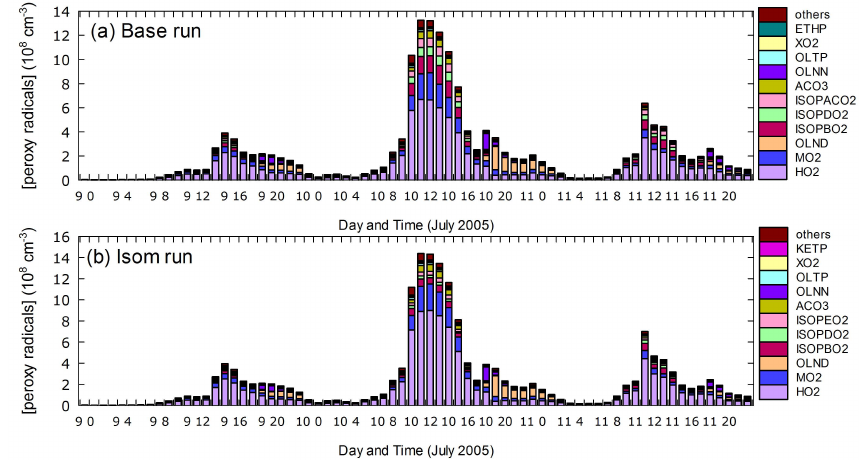
Fig. 2. Breakdown of peroxy radicals (HO 2 and RO 2 ) in the Base and Isom runs. MO2, OLND, OLNN, ACO3, OLTP, ETHP, KETP, and XO2 stand for methyl peroxy radical, NO 3 -alkene adduct (reacting via decomposition), NO 3 -alkene adduct (reacting to form HO 2 ) , saturated acylperoxy radicals, peroxy radicals from OLT (terminal olefins), peroxy radicals from ethane, peroxy radicals from ketones, and parameterized peroxy radicals accounting for additional NO to NO 2 conversions, respectively. Table 2. Descriptions of model